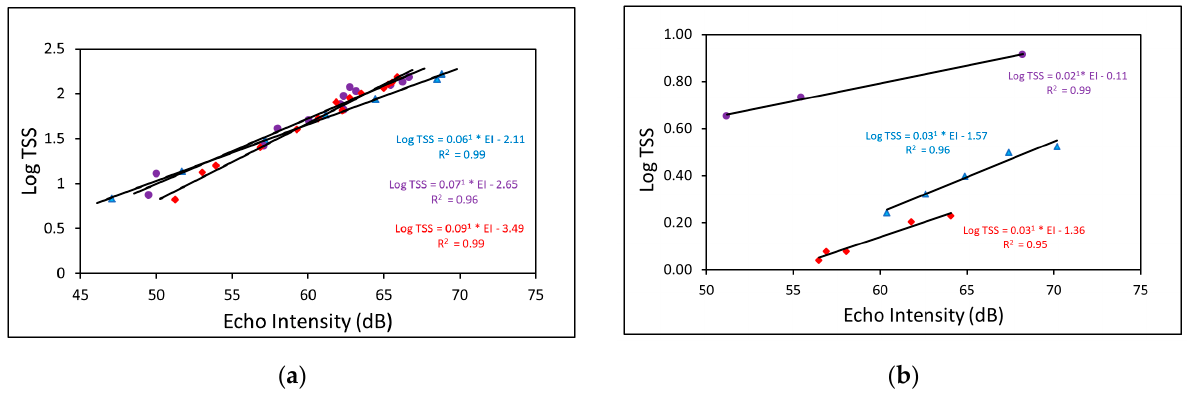
Figure 4. Calibration curves developed using the echo intensity (EI) from the ( a ) ADV and ( b ) ADCP at the upstream (UP), downstream (DS), and interior (INT) sites in the L − 29 Canal (for the ADCP, two data pairs/calibration points were removed at UP, while a pair each was removed at DS and IN to improve the fit of the